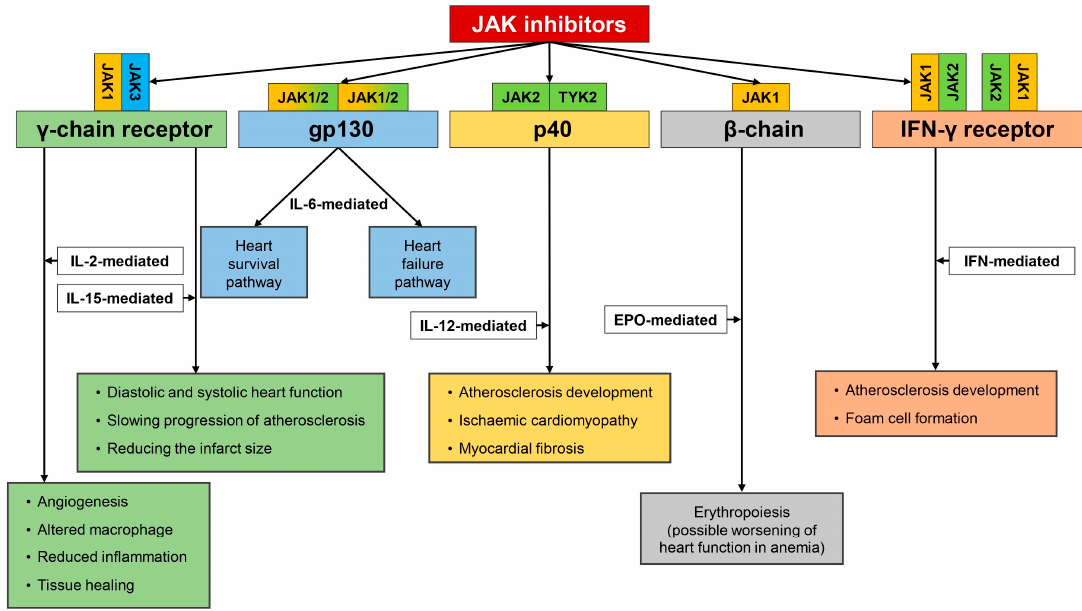
Figure 2. JAK inhibitors targeting JAKs of type I and II receptors. Based on cytokine